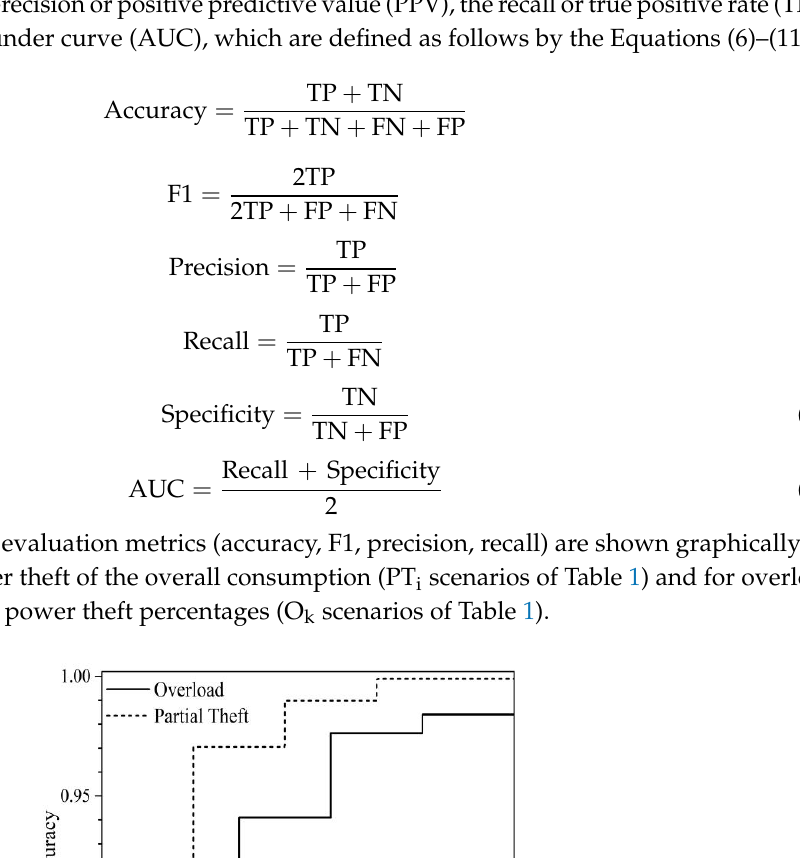
Figure 7. Confusion matrix for periodic and mix scenarios (PD m , M n ).